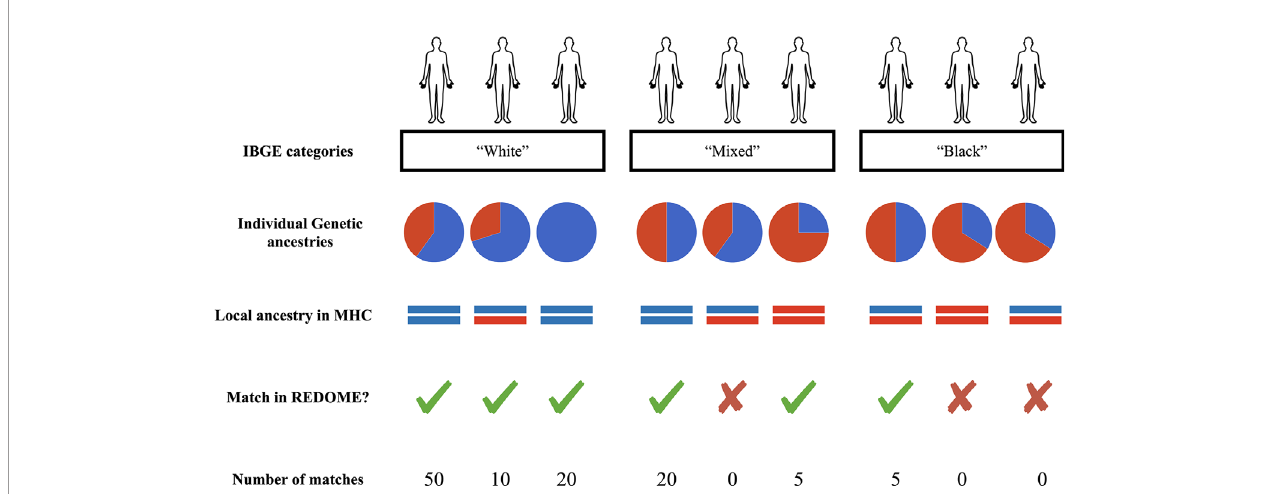
FIGURE 1 | Schematic representation of the strategy used in this study. Individuals are classi fi ed by three criteria: “ IBGE categories ” are self-identi fi ed categories de fi ned by the Brazilian Institute of Geography and Statistics (IBGE), based on phenotypic characteristics such as skin color, and can be “ Black ” , “ Mixed ” , “ Indigenous ” , “ White ” , and “ Yellow ” ; “ Genetic Ancestry ” is inferred with genetic markers spread throughout the genome, and describes the proportion of an individual ’ s genome that can be assigned to a continent of origin (with red and blue corresponding to African and European proportion ancestries respectively); “ MHC ancestry ” is the genetic ancestry of the segment of chromosome 6 including the MHC region within an individual (again, with red and blue corresponding to African and European ancestries). For each individual, classi fi ed with these criteria, we queried REDOME for the presence of a matching genotype and recorded the number of matches, when they were